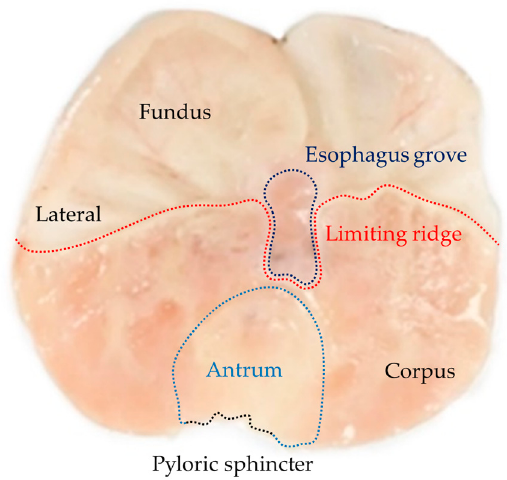
Figure 1. Rat stomach opened at the greater curvature showing the main anatomical parts: the fundus, esophagus grove (purple), limiting ridge (red), antrum (blue), and corpus pyloric sphincter (black).